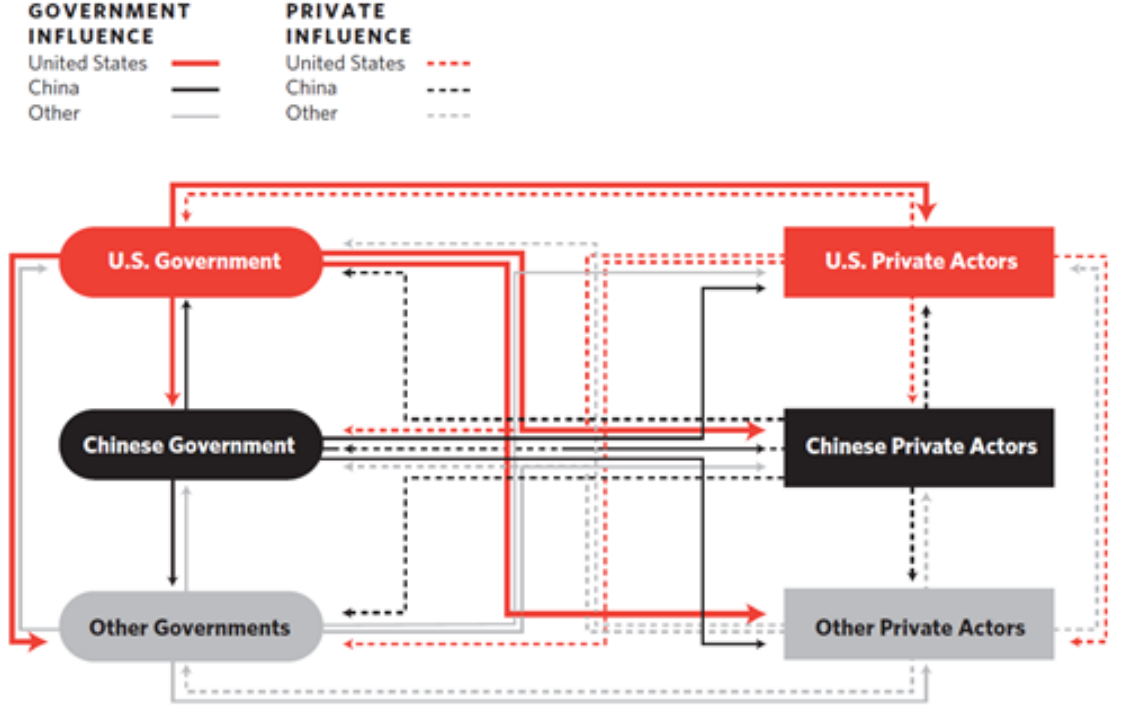
Figure 3. The US government is just one of many actors shaping technological decoupling. Source: US –CHINA TECHNOLOGICAL “DECOUPLING”— A STRATEGY AND POLICY FRAMEWORK (2022).